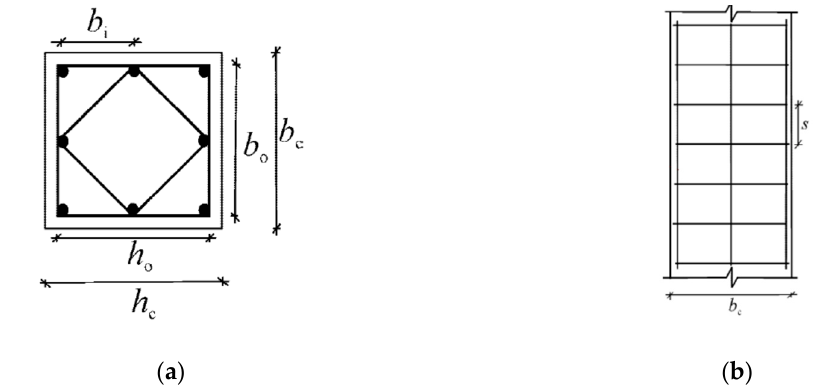
Figure 2. ( a ) Horizontal and ( b ) vertical cross-section of column with non-uniform distribution of confining stresses (EN 1998-1:2004